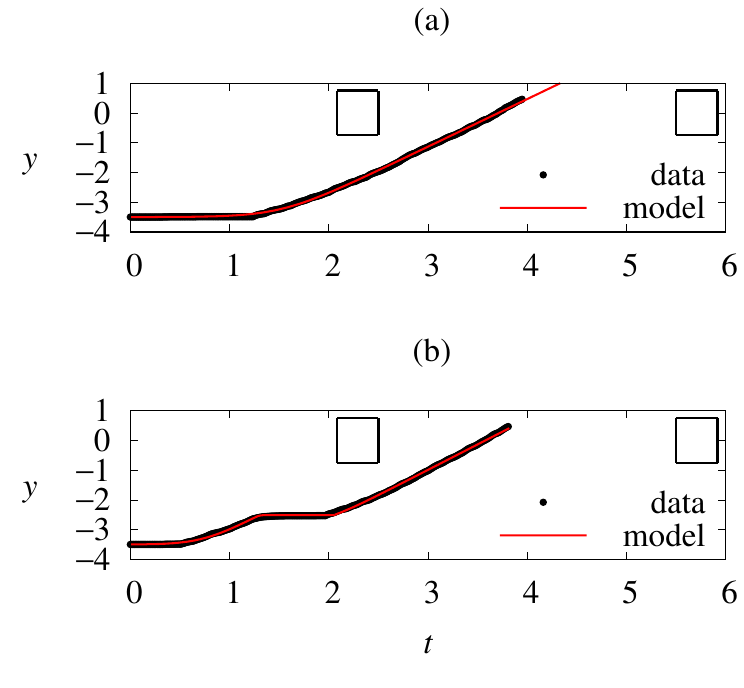
Figure 3. Pedestrian position-time plots illustrating typical crossing patterns. Black traces indicate example data; red traces indicate the corresponding model fits. Left and right boxes indicate the temporal and spatial area that the leading and the trailing vehicles occupy, respectively. Intersecting one of the box lines would indicate a collision. In both examples, the conditions are described by y 0 = − 3.5 m, t g = 3.0 s, and v c = 30 km/h, with the vehicle type set to be a sedan. ( a ) an example of the simple cross with a single acceleration event followed by constant speed walking; ( b ) an example of the two-step cross with two acceleration